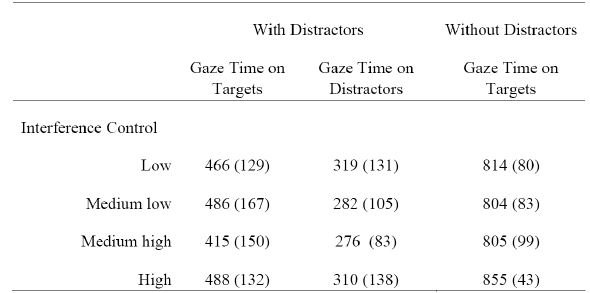
Table 3: Mean gaze time on targets and on distractors as a function of interference control group and of stimuli (stimuli of the working memory task presented with or without distractors; condition with distractors